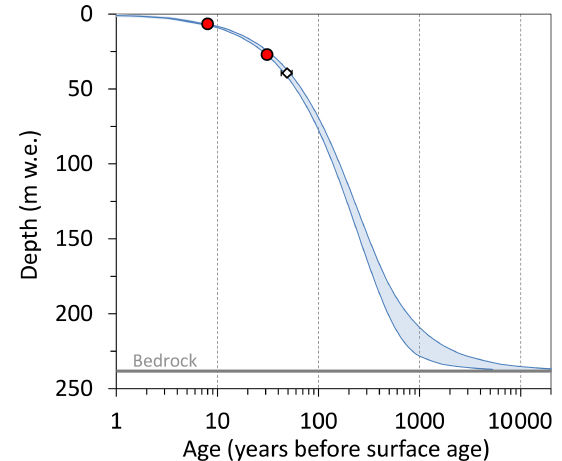
Figure 6. Model-based estimate of the age–depth relationship down to bedrock for the ADA16 drill site. Red dots show the 1986 and 1963 137 Cs horizons used to fit the model. The estimated age for the bottom of the 46m long ADA16 ice core is shown in addition (open diamond, not used for model tuning). The shaded area indicates the range of estimates as confined by the upper and lower uncertainty bounds (thin blue